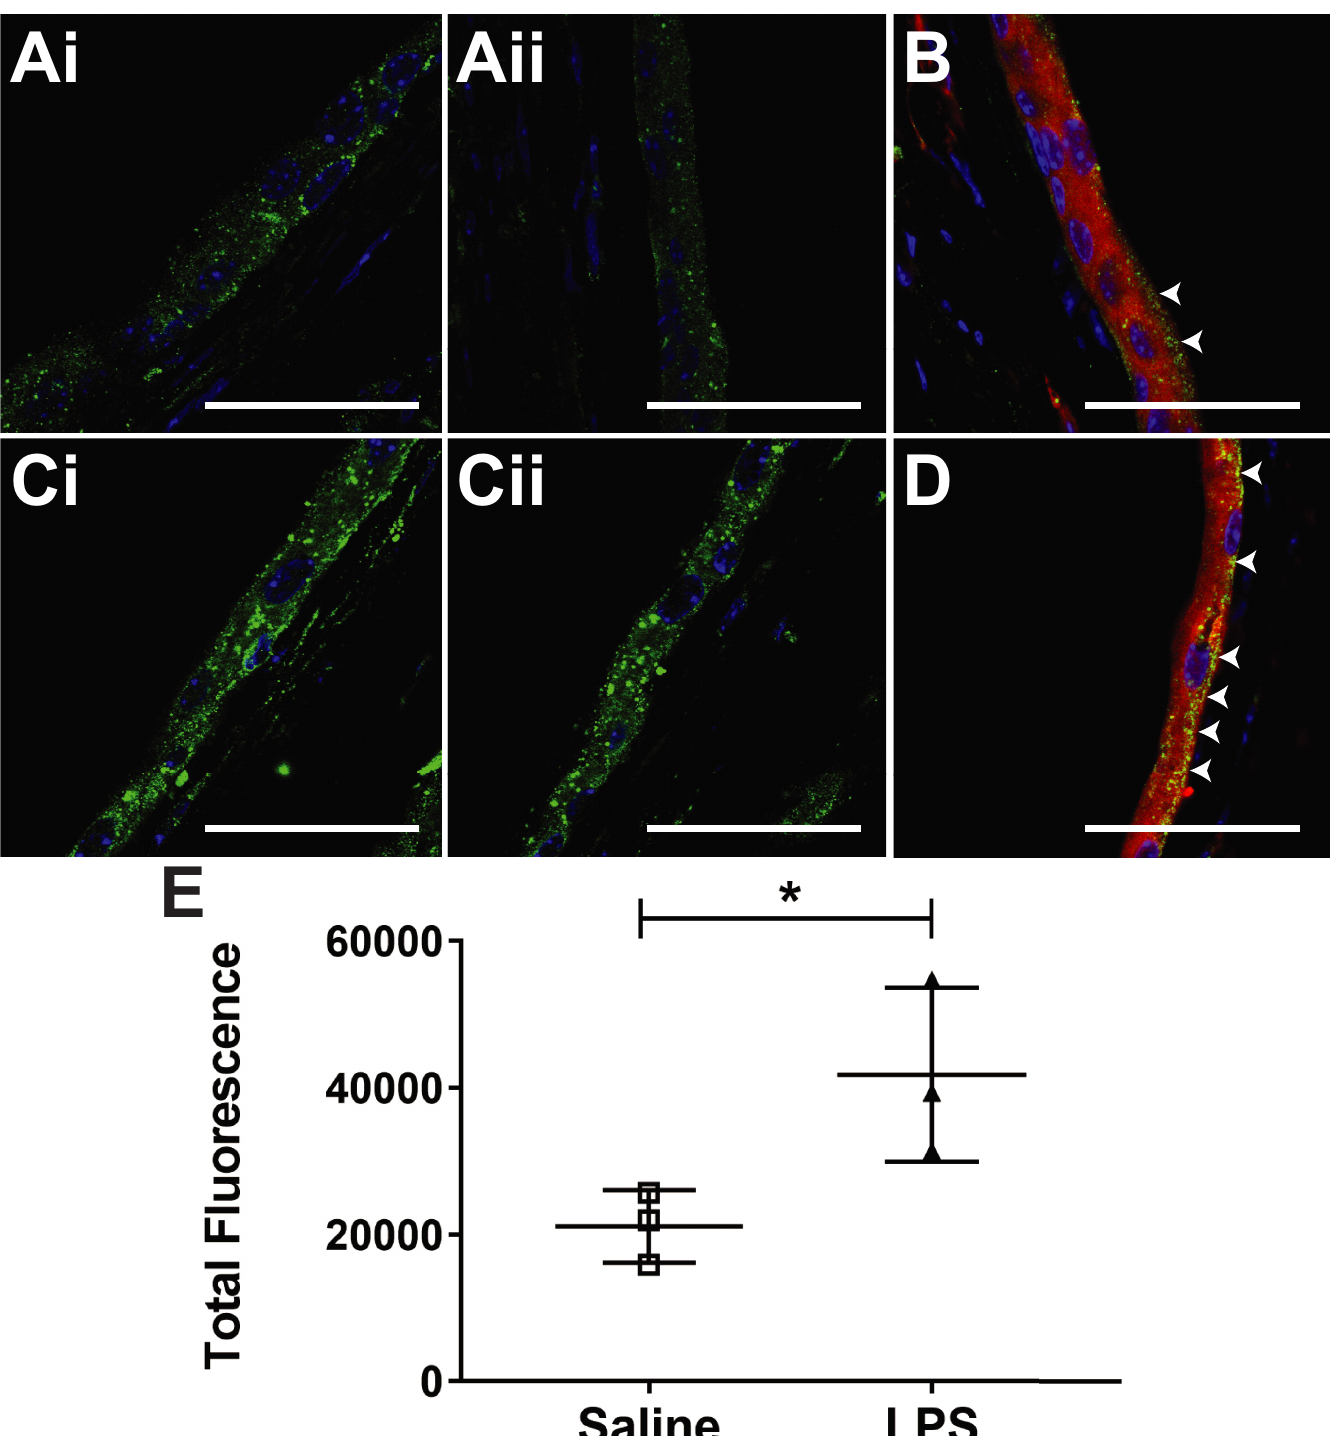
Fig 3. Ex vivo claudin-2 levels detected by immunofluorescence (IF) are elevated in LPS-exposed URO-MCP-1 transgenic mouse model for IC. Representative IF images obtained from excised ex vivo URO-MCP-1 mouse bladders treated with either saline (A) or LPS (C). Representative co-localization IF images of claudin-2 (green) and ZO-1 (red) for either saline (B) or LPS (D)-treated mouse bladders. White arrow heads indicate tight-junction regions with high co-localization areas for both claudin-2 and ZO-1. Claudin-2 was stained with Alexa Fluor 488 (green), ZO-1 was stained with Alexa Fluor 594 (red), and cell nuclei are stained with DAPI (blue). IF claudin-2 stained images (i and ii). Note higher levels of IF staining for claudin-2 in LPS-exposed URO-MCP-1 urothelia within mouse bladders (Ci and Cii). Claudin-2 seems to be detected in the plasma membrane, cytoplasm, per-nuclear, as well as the tight junctions, however co-localization with ZO-1 seems to